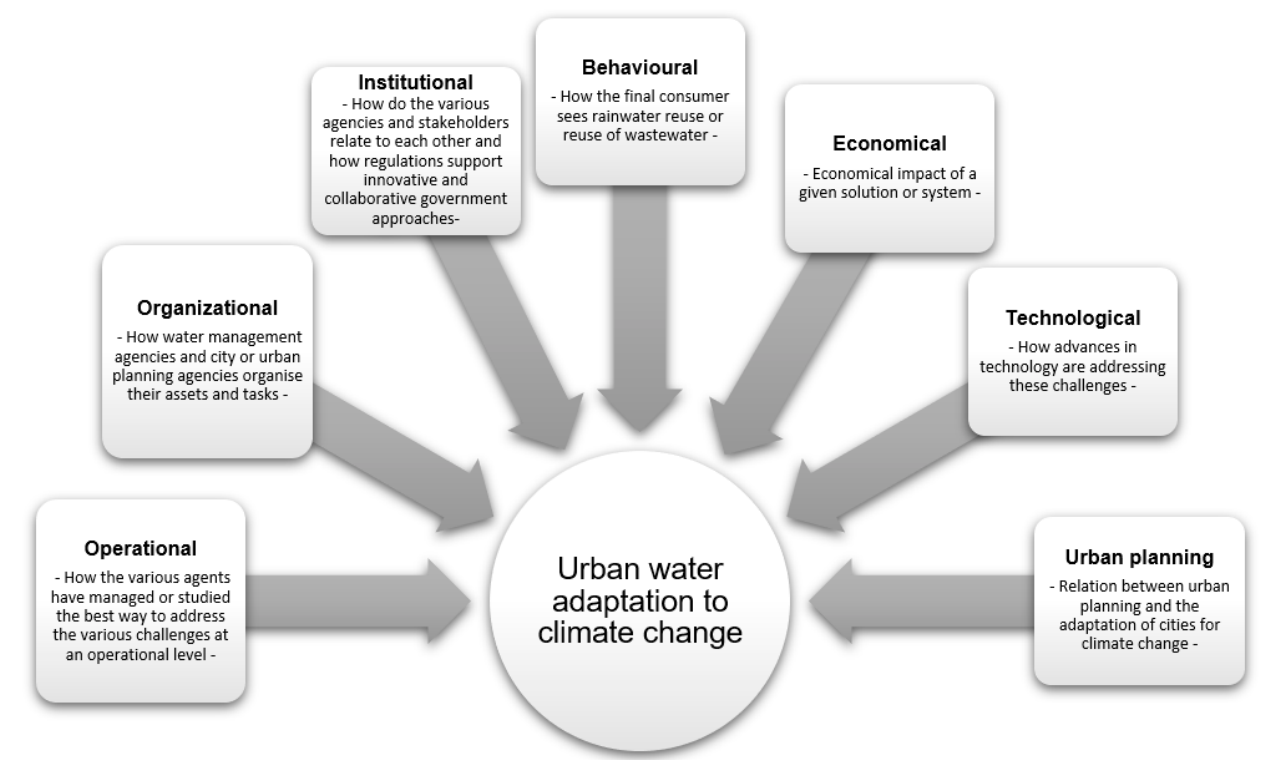
Figure 4. Main vectors contributing to the urban water management adaptation to climate change, according to the literature review. Table 4. Synthesis of the approaches to tackle climate change and urbanisation in the water sector.